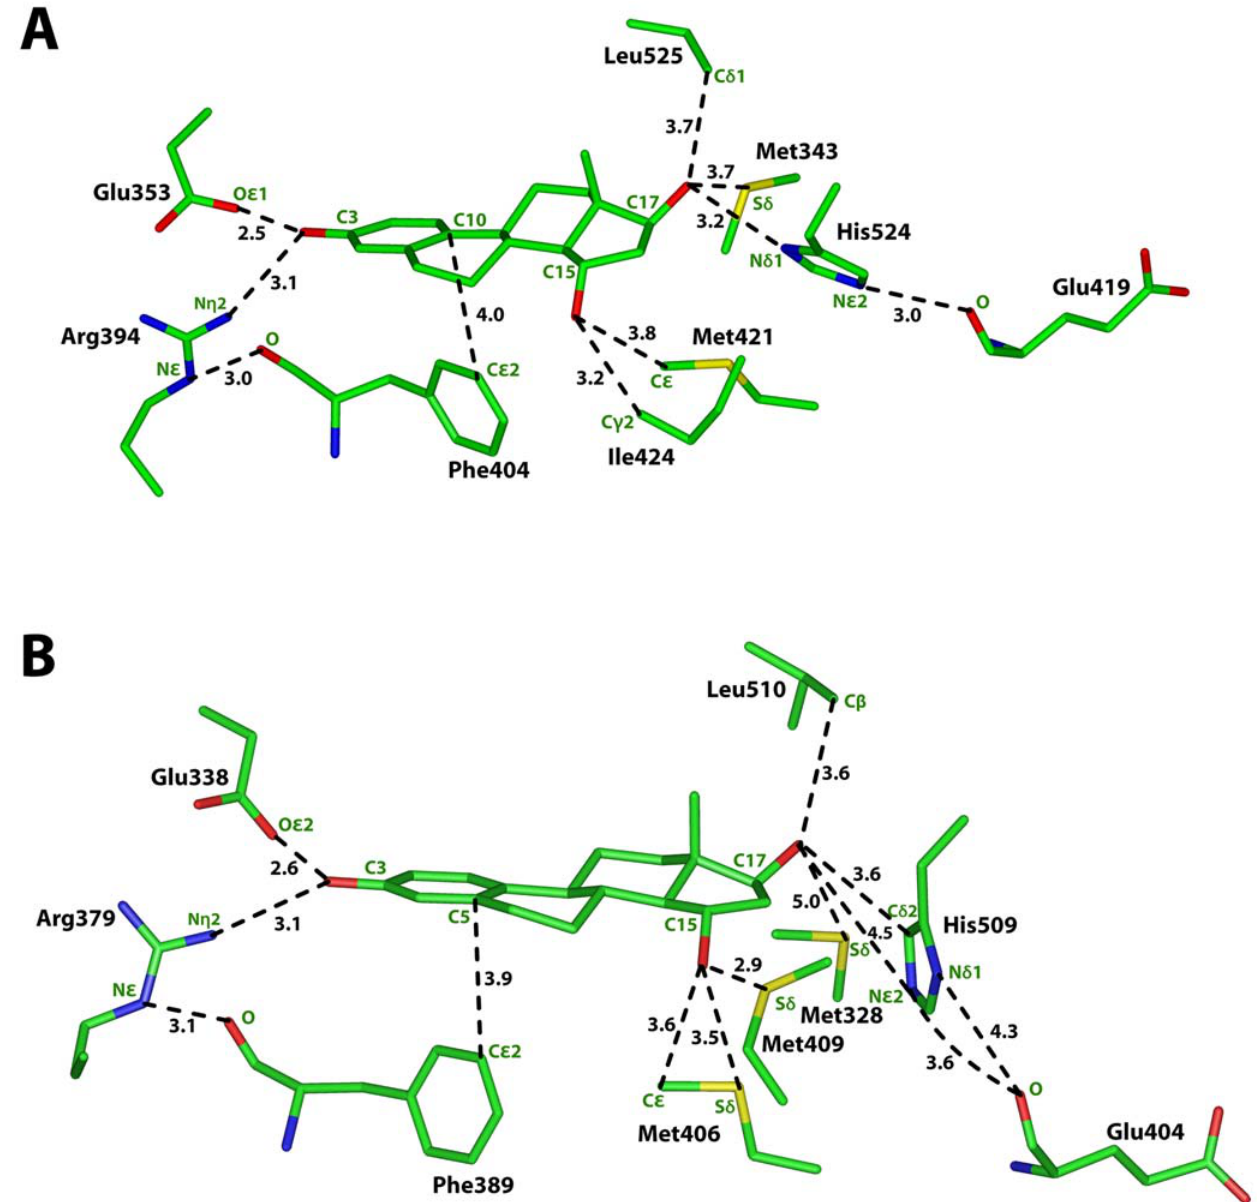
Figure 5. Interaction of 15 a -OH-E2 with human ER a and the 3D model lamprey ER. A. In human ER a , C c 2 on Ile-424 and C e on Met-421 have van der Waals contacts with 15 a -OH-E2. B. Lamprey ER has stabilizing interactions with the A ring of 15 a -OH-E2 that are similar to those in human ER a . His-509 has rotated and does not form a hydrogen bond with the C17-hydroxyl on E2. C d 2 on His-509 has a van der Waals contact with the C17-hydroxyl. S d on Met-406 and Met-409 stabilize 15 a -OH-E2.